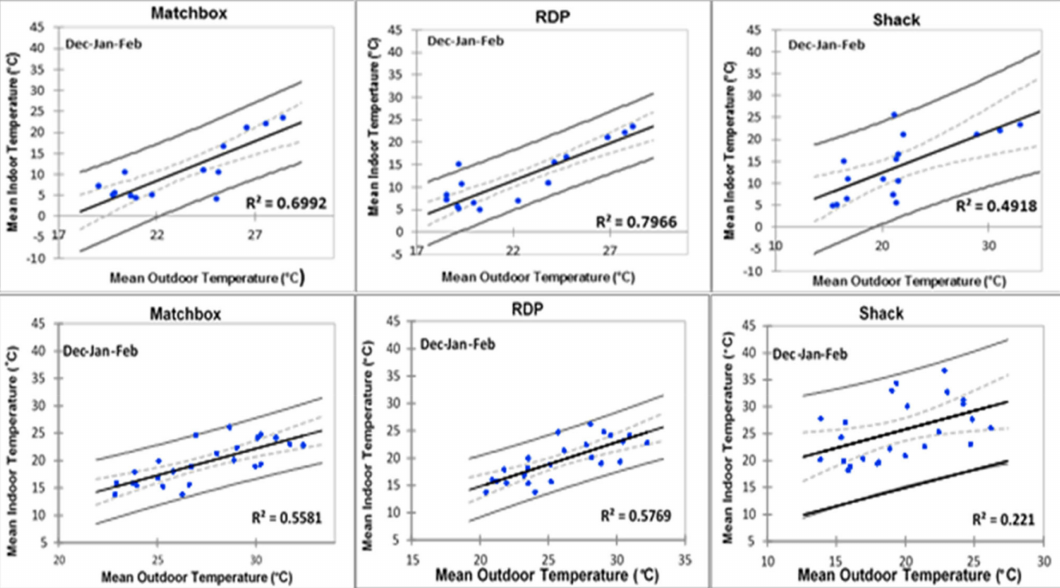
Figure 11. Regression models of three housing types in Kathorus (top row) and Wakkerstroom during warmer months, with a confidence interval of 95% (d.f. =